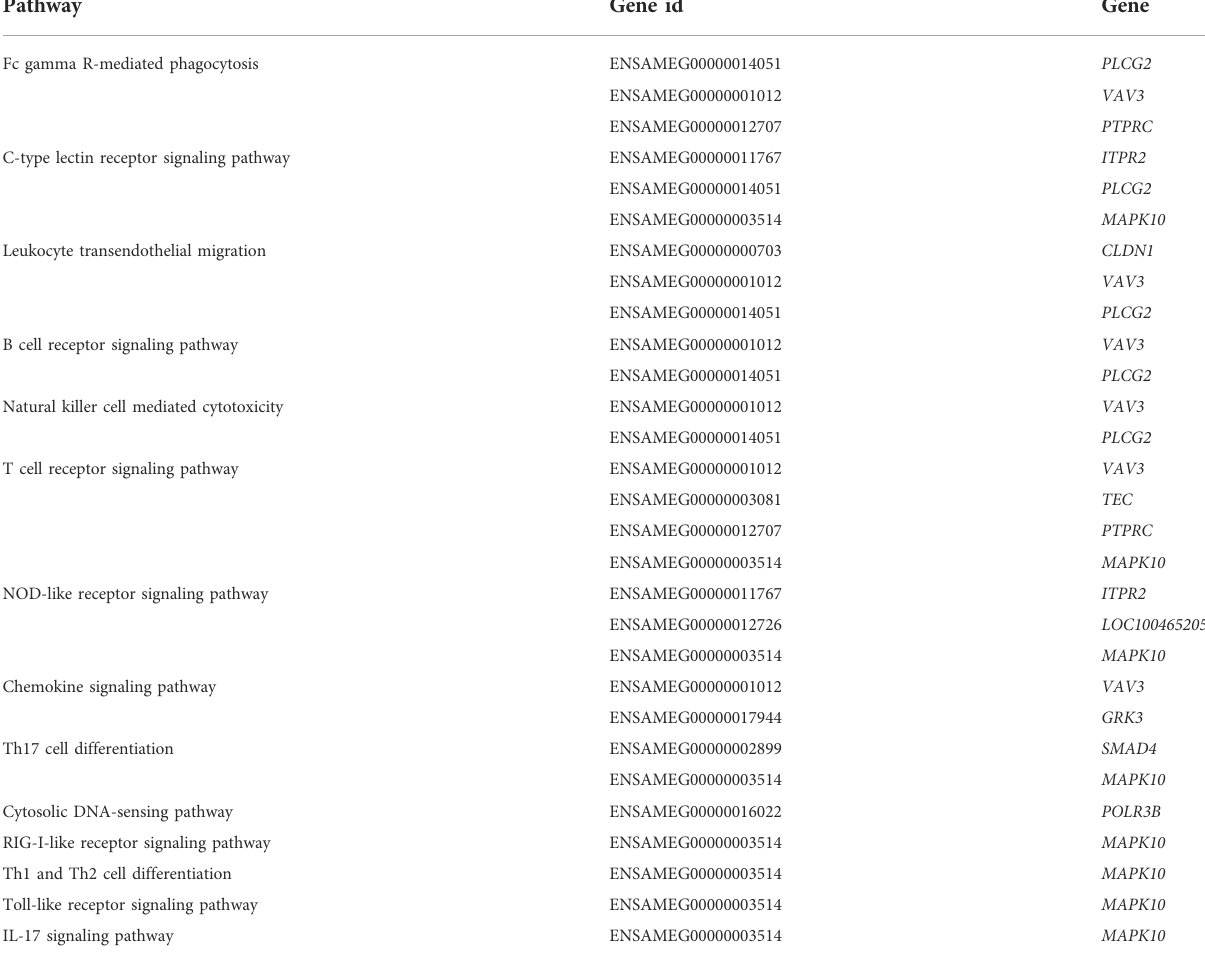
TABLE 3 Immune pathways and the enriched DMGs in KEGG pathway enrichment